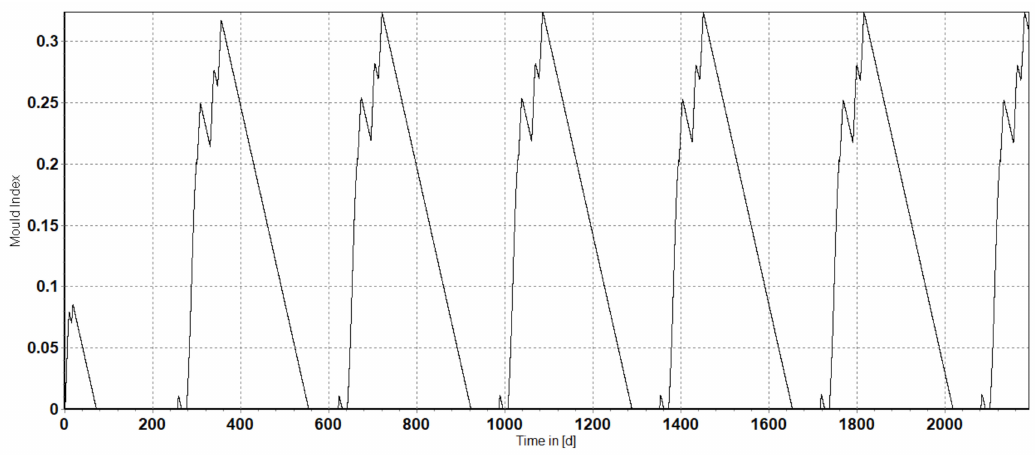
Figure 10. Mold growth index value on the interior side of the vapor retarder. Reproduced with permission from [11].